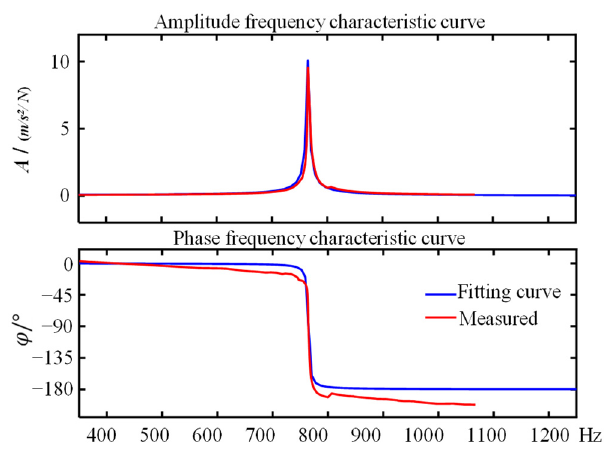
Figure 4. Fitting frequency characteristic curve of a resonance mechanism.